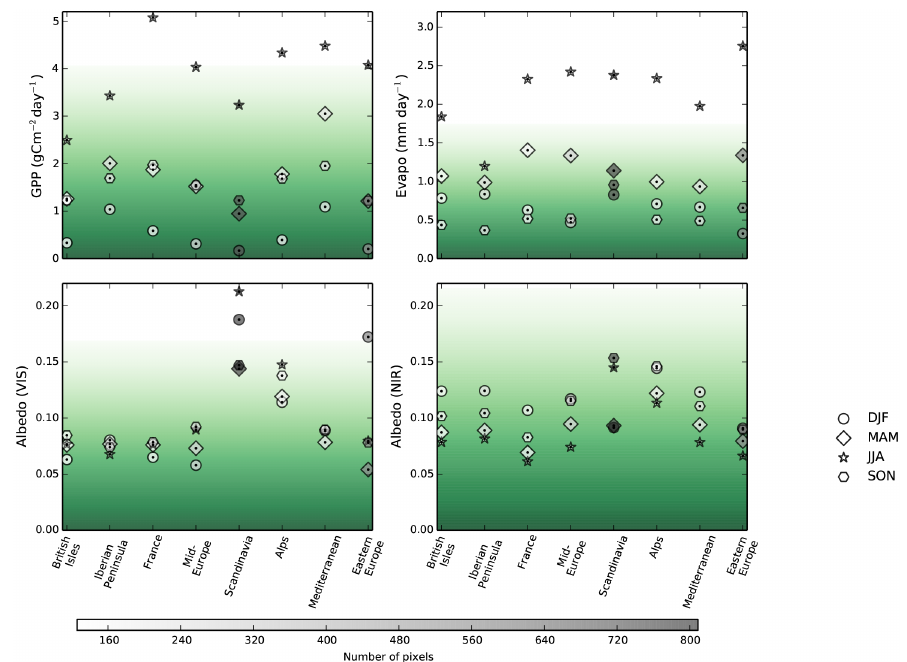
Figure 3. Root mean square error of ORCHIDEE trunk for gross primary production, evapotranspiration and visible and near-infrared albedo for different regions and periods (DJF: December–February; MAM: March–May; JJA: June–August; SON: September–November). The grey scale of the symbols indicates the number of pixels included in the calculation. The transition from green to white indicates an RMSE of 100%.